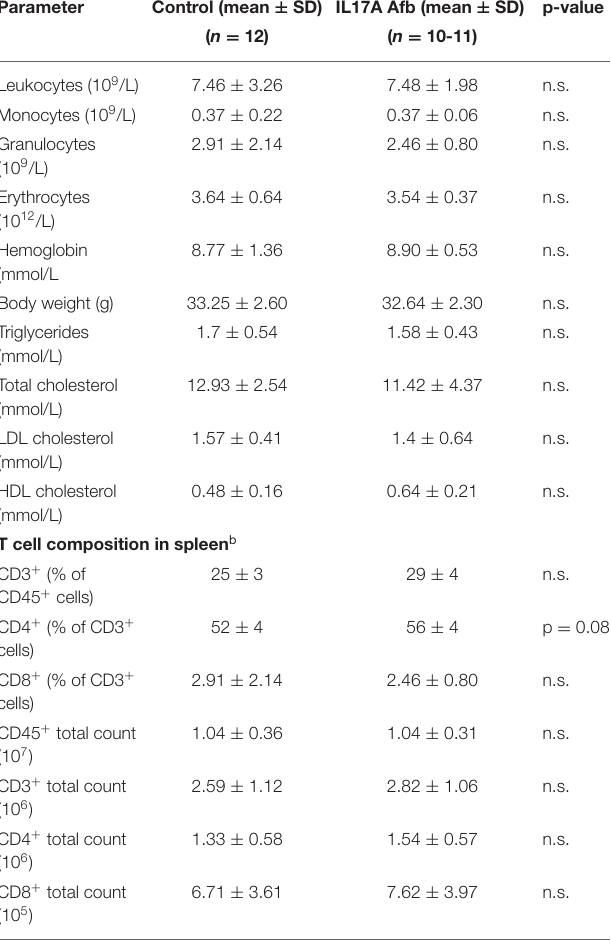
TABLE 1 | Blood and morphometric parameters a and T cell subsets in spleen b .